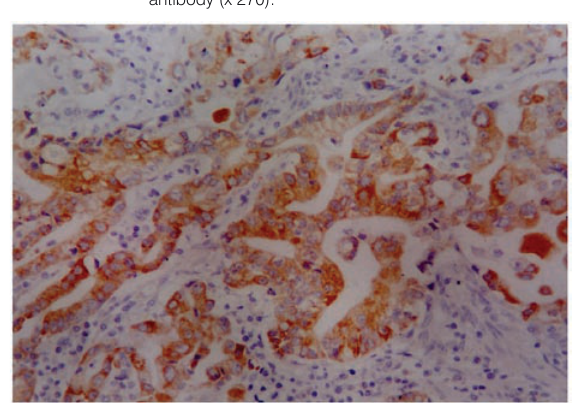
Figure 2. High intensity TS staining of gastric adenocarcinoma detected by immunohistochemistry using TS106 antibody (x